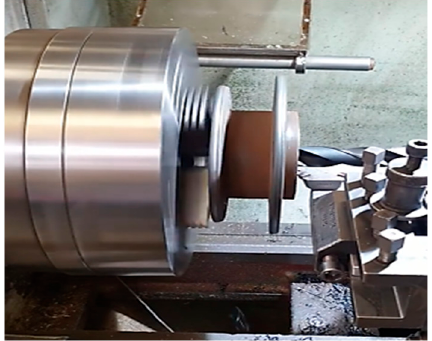
Figure 6. Excess material removals from the substrate.